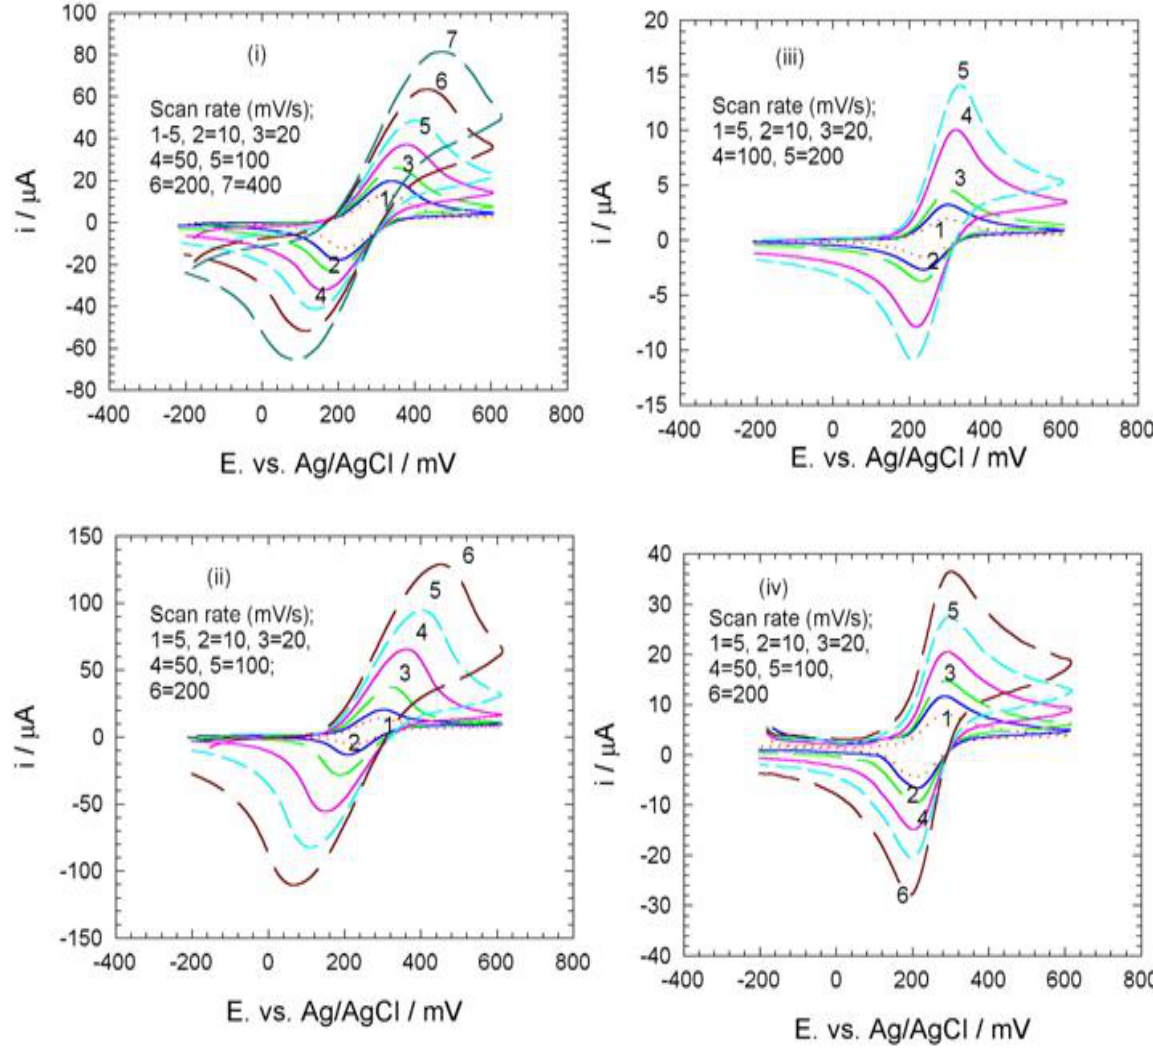
Figure 3. Cyclic voltammograms of ormosil-modified electrodes in 0.1 M phosphate buffer pH 7 at different scan rates; (i) Ormosil-modified lectrode without palladium chloride treatment; (ii) 0rmosil-modified electrode in the presence of palladium chloride and in absence of palladium chloride treatment; (iii) Ormosil-modified electrode with palladium chloride treatment using a drop of palladium chloride; (iv) ) Ormosil-modified electrode with palladium chloride treatment by dipping the electrode in palladium